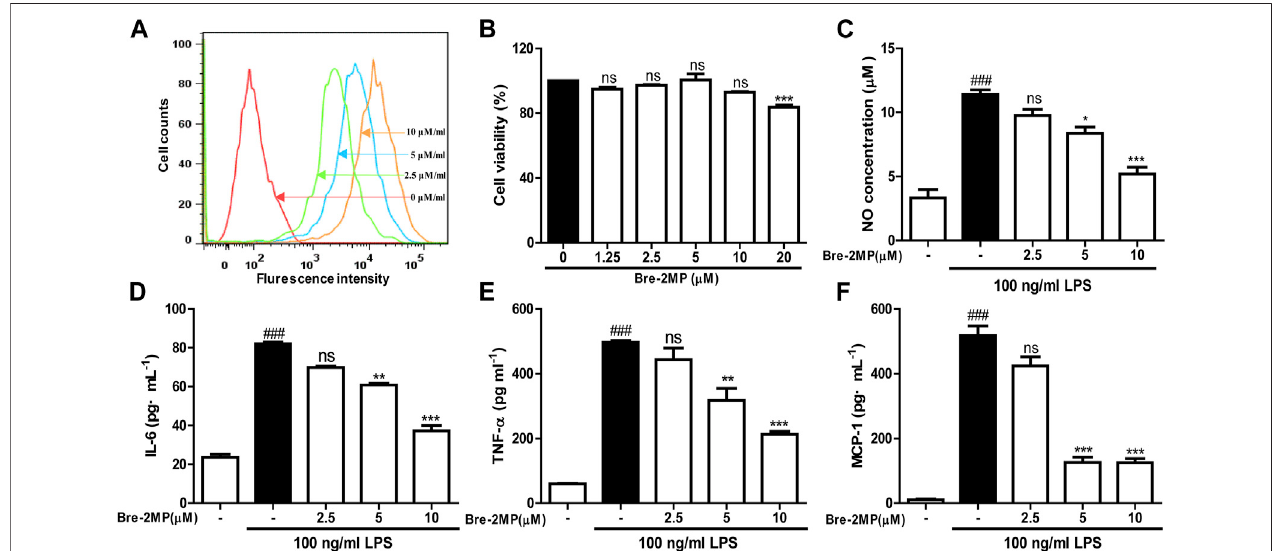
FIGURE 4 | Effects of brevinin-2MP on lipopolysaccharide (LPS)-induced production of nitrite and cytokines. (A) The binding of brevinin-2MP to RAW 264.7 cells. FITC-labeled brevinin-2MP (2.5, 5, and 10 μ M) were incubated with RAW 264.7 cells for 15 min at 37 ° C before fl ow cytometry analysis was carried out. (B) Effect of brevinin-2MP on the viability of RAW 264.7 cells. (C – F) Effect of brevinin-2MP on the production of NO, IL-6, TNF- α , and MCP-1 in RAW 264.7 cells induced by LPS. Data are mean ± SEM ( n (cid:1) 4). p p < 0.05, pp p < 0.01 and p < 0.001 indicate signi fi cant difference compared with the control that was incubated with 100 ng/mL LPS. ### p < 0.001 indicates signi fi cant difference in comparison with the control without LPS and brevinin-2MP.